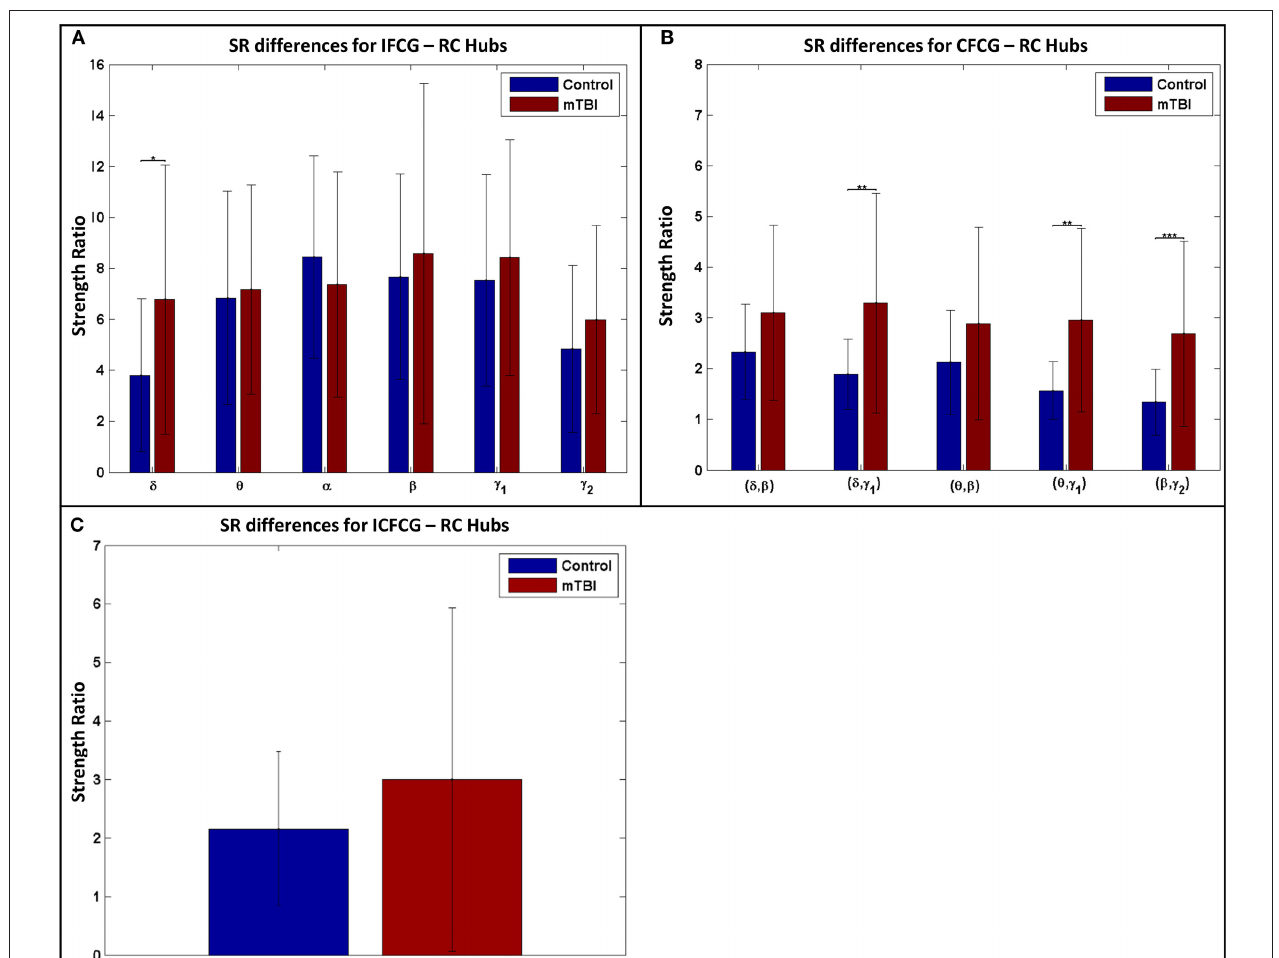
FIGURE 7 | Strength ratio SR for (A) IFCGs, (B) CFCGs, and (C) ICFCGs. All comparisons (paired test linked by *) reached statistical significance ( p -value: * < 0.05; ** < 0.01, and *** < 0.001).